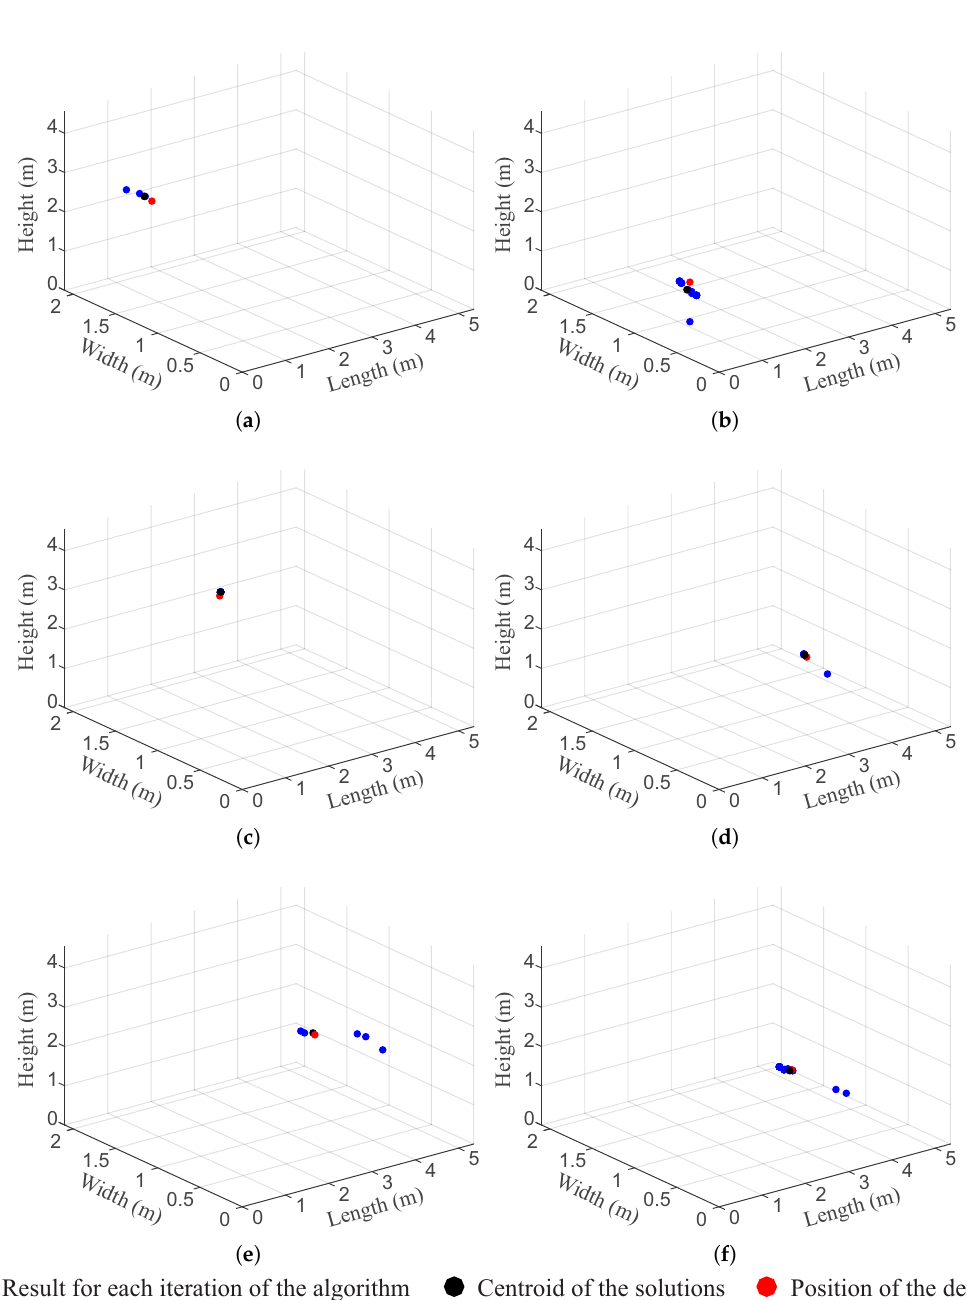
Figure 9. Results of the localisation algorithm: ( a ) Defect in position 1, ( b ) defect in position 2, ( c ) defect in position 3, ( d ) defect in position 4, ( e ) defect in position 5, and ( f ) defect in position